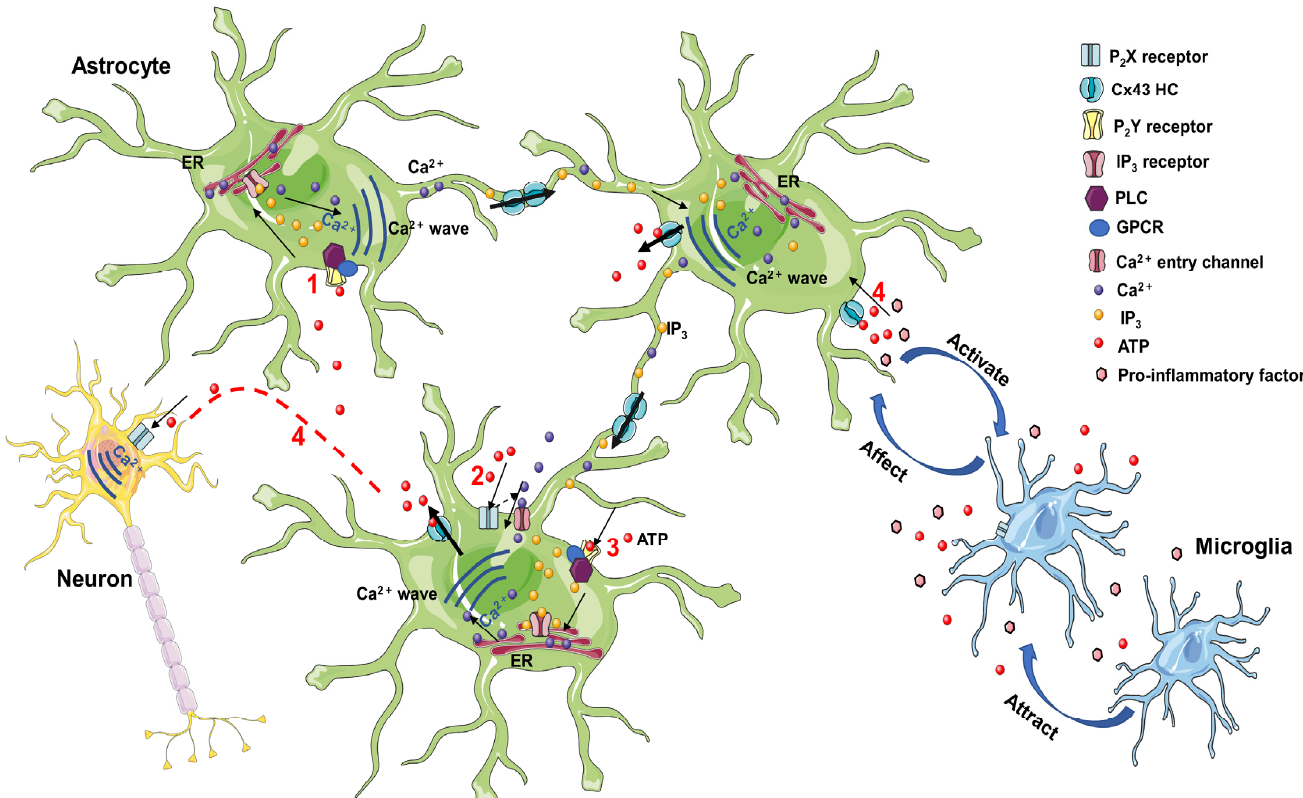
Figure 2. (1) Extracellular ATP stimulation to the activation of PLC and the formation of IP 3 , which, upon binding to ER receptors, promotes the release of Ca 2+ stored in the ER. IP 3 and Ca 2+ diffuse to adjacent cells through GJC, resulting in the diffusion of intracellular Ca 2+ waves. (2) Extracellular